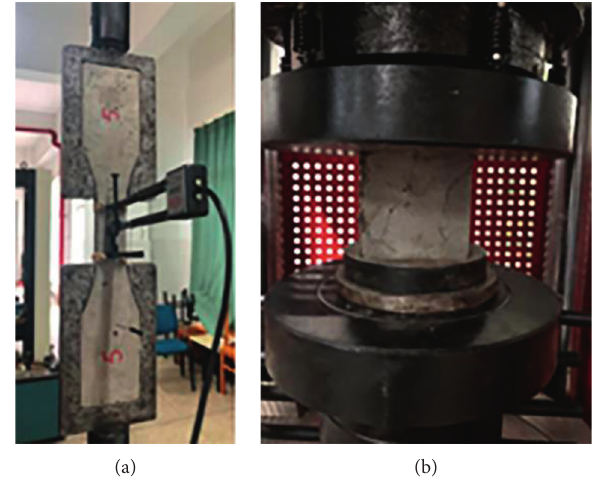
Figure 1: Tensile and compression test. (a) Tensile test. (b) Com- pression